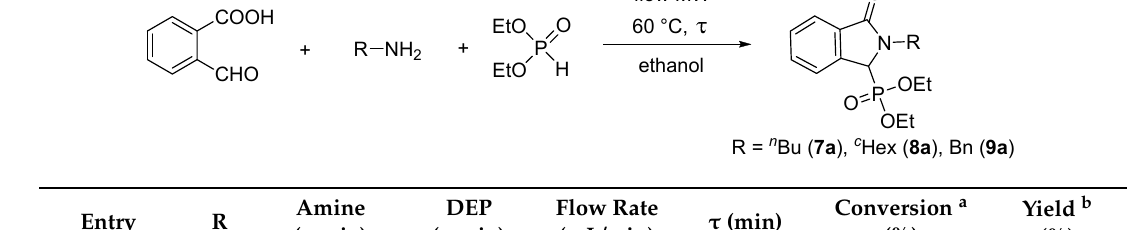
Table 2. Optimization of the condensation of 2-formylbenzoic acid, aliphatic primary amines and diethyl phosphite in a continuous flow MW reactor.